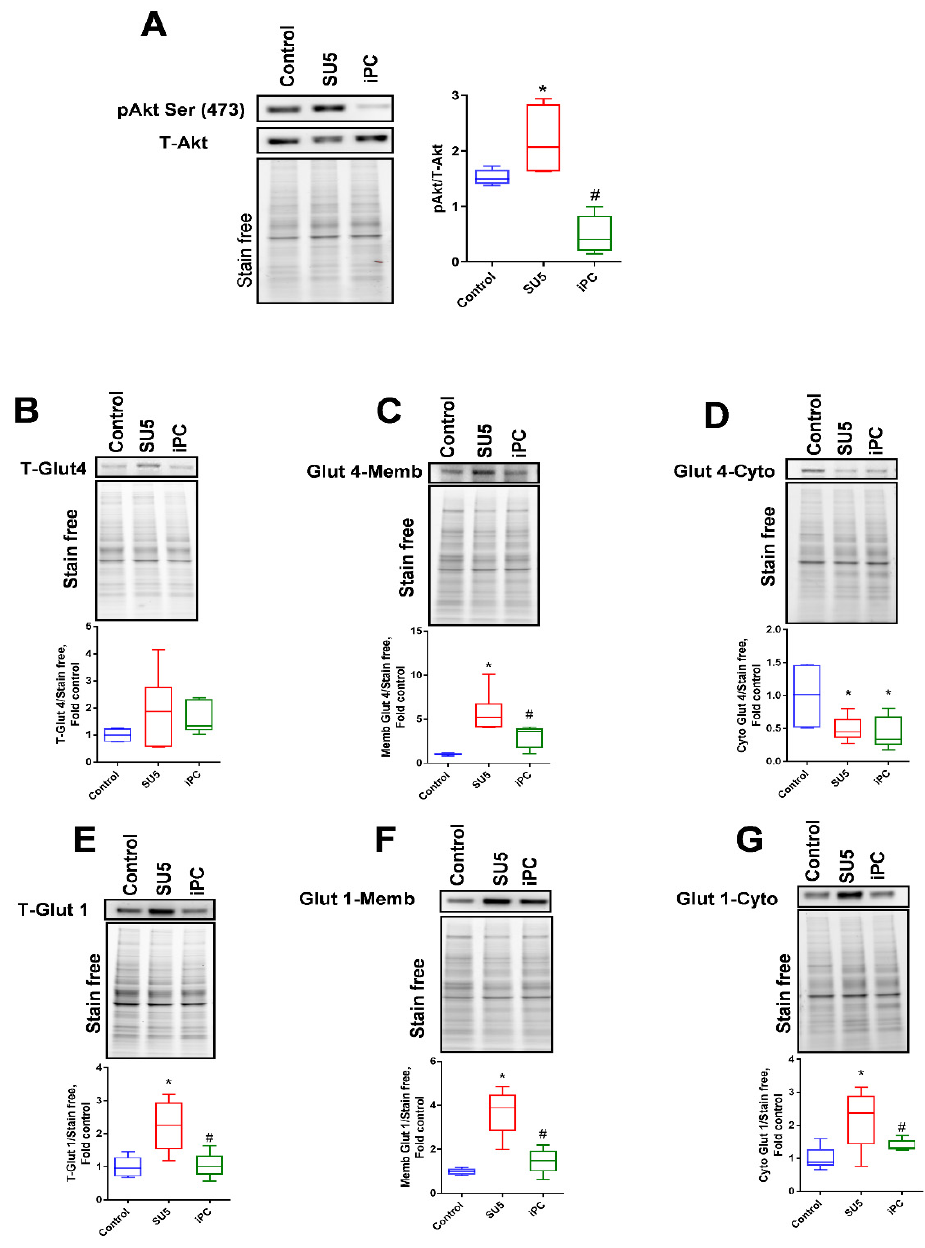
Figure 2. PC inhibitor reduced protein kinase B (Akt) phosphorylation and glucose transporters. ( A ) Akt phosphorylation ratio was significantly increased in the SU5 group was significantly downregulated with PC inhibitor treatment. ( B ) Glucose transporter Glut 4 (total) expression was not significantly altered, but ( C ) in the SU5 group, Glut 4 membrane expression was found increased and it was found decreased in ( D ) cytosolic fraction. PC inhibitor treatment significantly attenuated Glut 4 translocation from the membrane to the cytosol. Another glucose transporter, Glut 1, showed increased expression; ( E ) total glut 1 expression in whole lung lysate, ( F ) Glut1 expression in the membrane fraction and ( G ) Glut1 expression in the cytosolic fraction. Data expressed as box-and-whisker plot with median value ± min max, N = 5–6, * p < 0.05 versus control, # p < 0.05 versus SU5 by ANOVA.